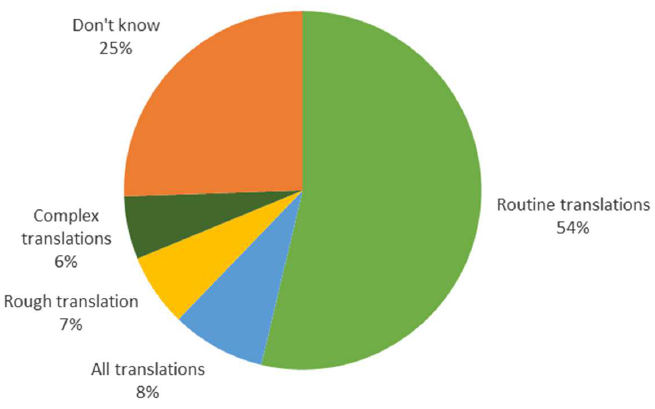
Figure 8. Which type of translation activity will use AI? N = 106.